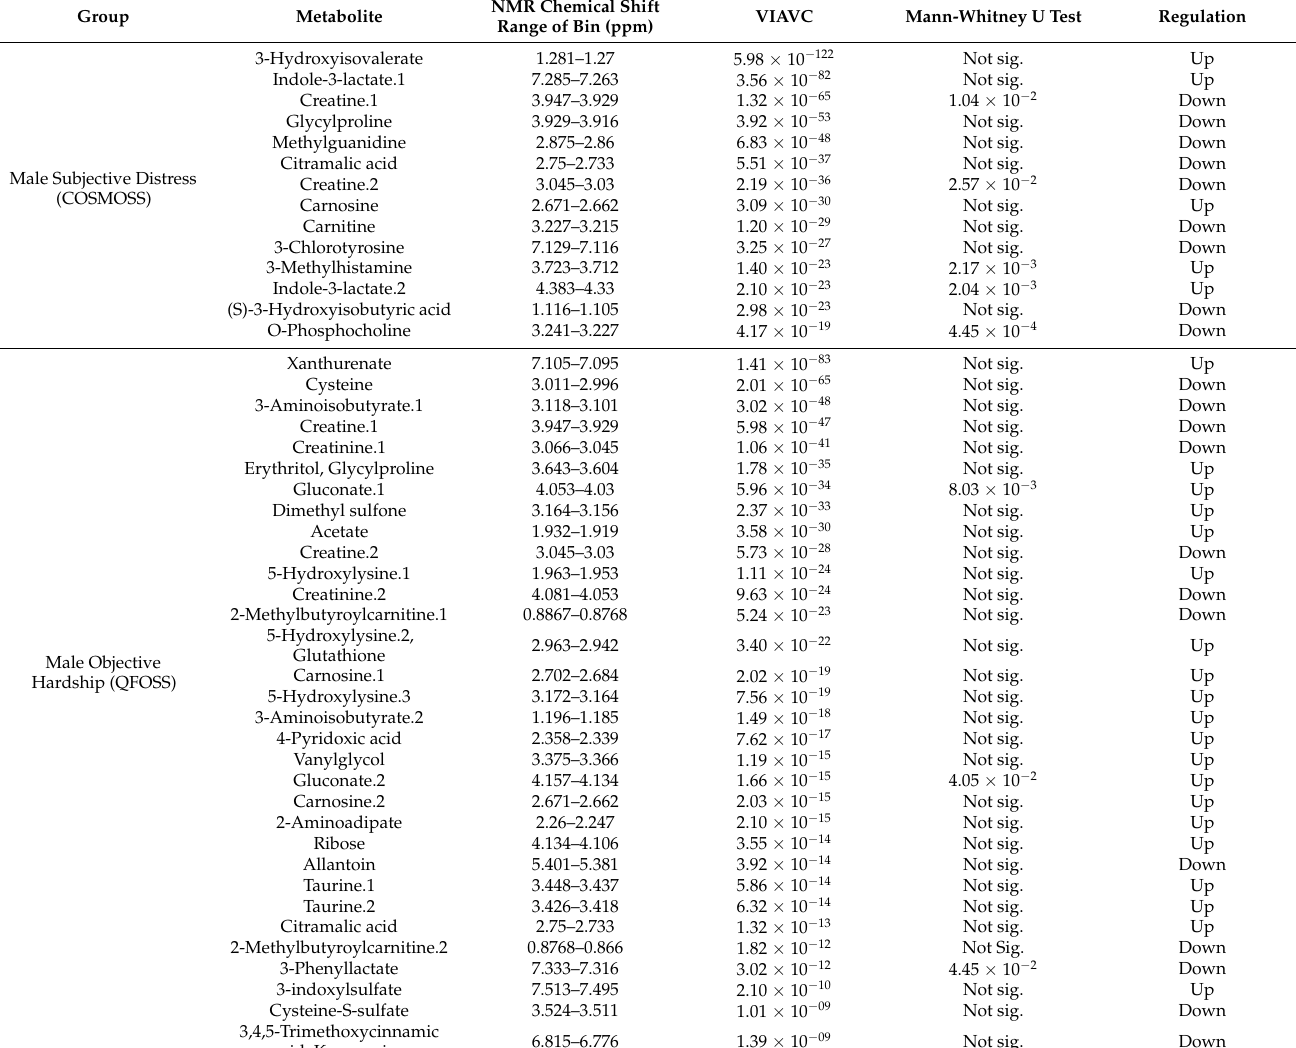
Table 1. Males: Statistically significant urinary metabolites identified by VIAVC or MW testing in the comparison of high and low maternal composite subjective distress and objective hardship in males. Significance was determined using a p -value equal to or less than 0.05. Metabolites are displayed in order of VIAVC p -value. Regulation relates to the high-strM Metabolites with more than one NMR resonance peak are represented in order of ppm as metabolite.1, metabolite.2,